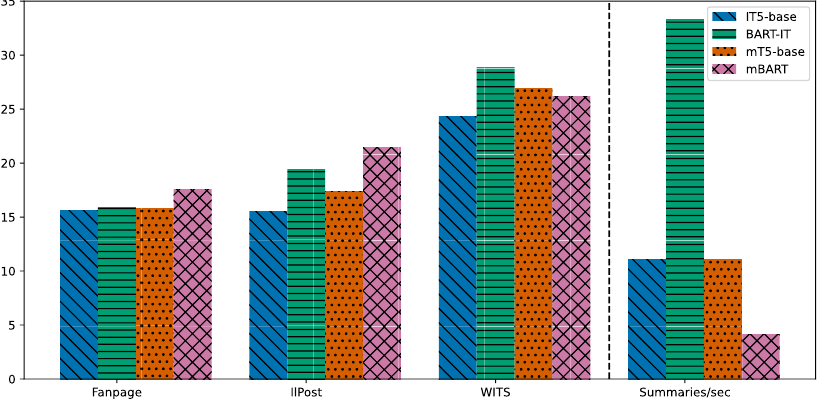
Figure 1. ROUGE-2 comparison between IT5, BART-IT, mT5, and mBART on benchmark datasets. The last four bars represent the performance of the models in terms of summaries/second on a single NVIDIA A6000